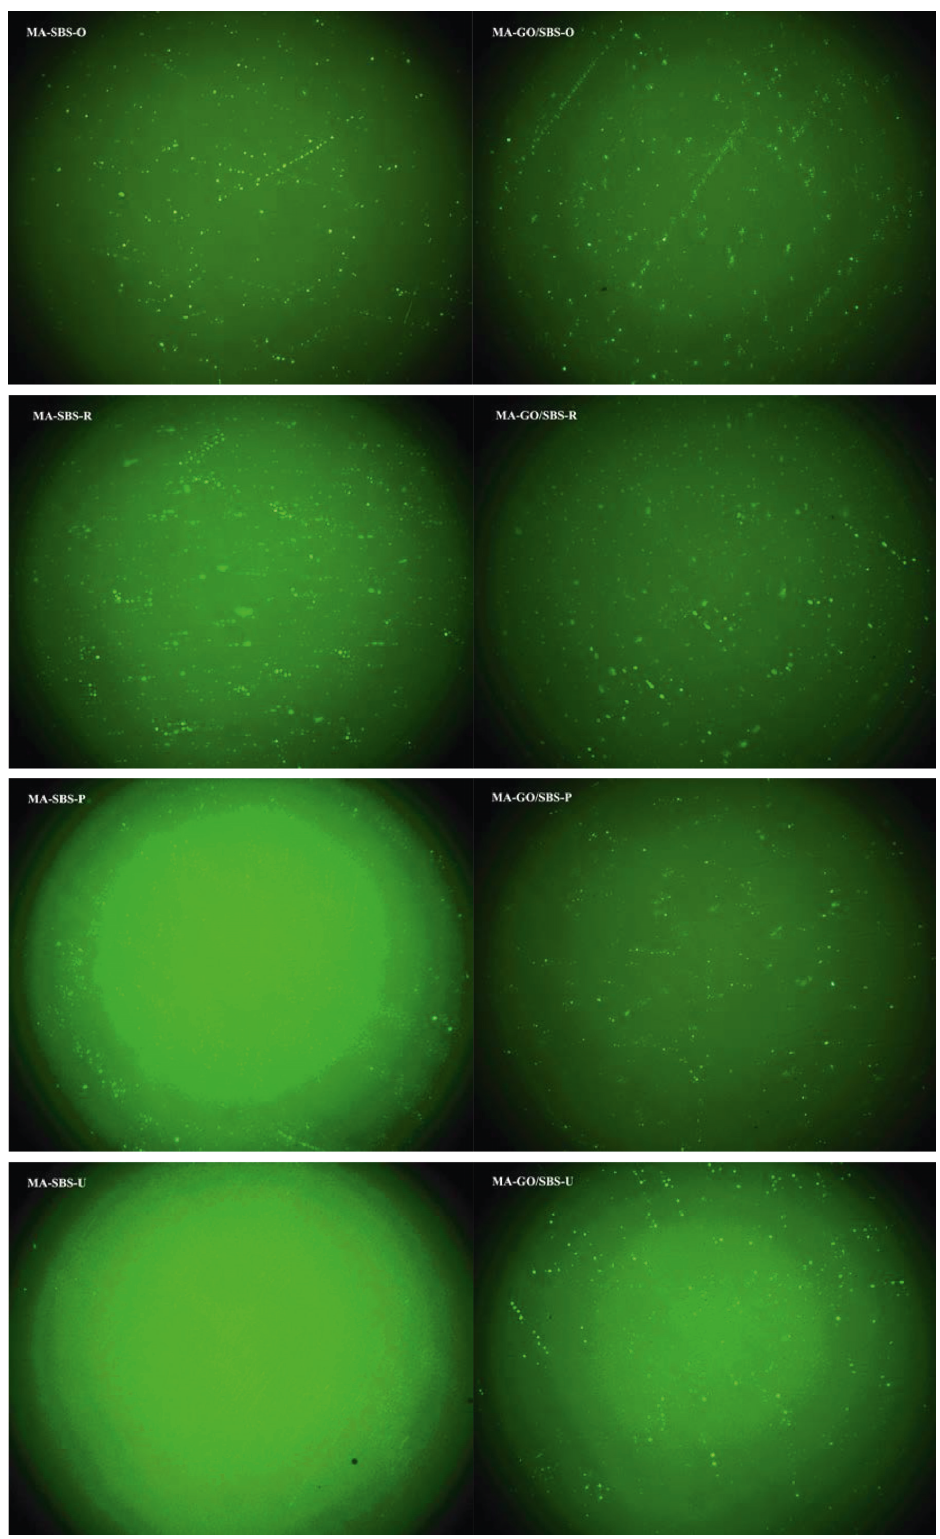
Figure 8: Fluorescence images of MA-SBS and MA-GO/SBS at different aging